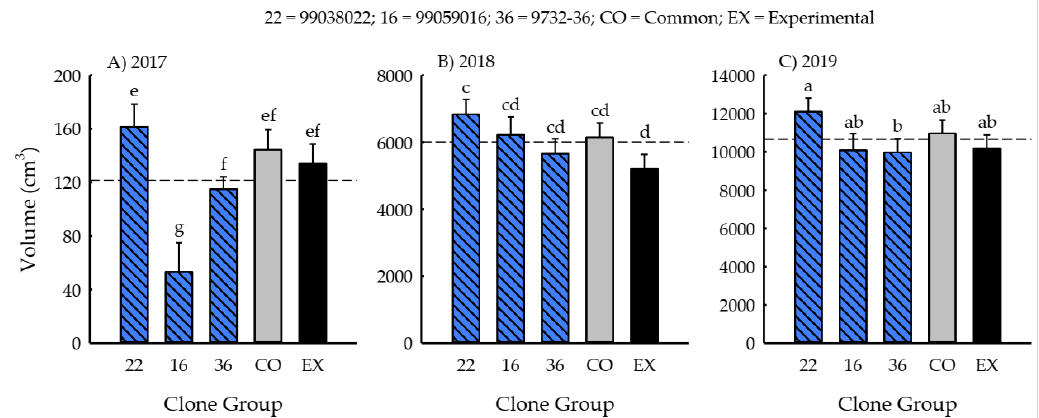
Figure 6. First- ( A ), second- ( B ), and third-year ( C ) volume ( ± one standard error) of three clone groups (i.e., NRRI = 22, 16, 36; Common; Experimental; see Table 3 for definitions) tested in six phytoremediation buffers (i.e., phyto buffers) established in 2017 (i.e., the 2017 Buffer Group) in the Lake Michigan watershed of eastern Wisconsin, USA. The dashed line represents the overall mean, and asterisks indicate means different than the overall mean at p < 0.05. Bars with different letters across all clone group × year combinations are different at p <